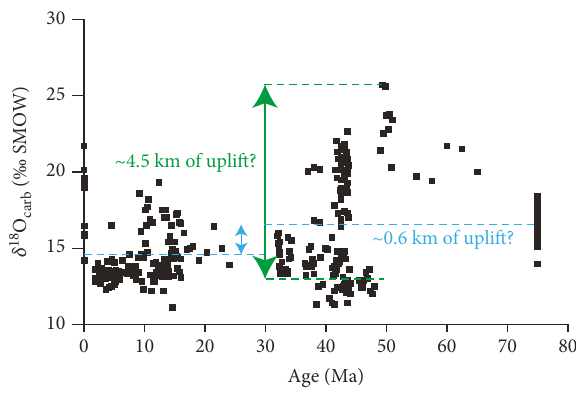
Figure 1: Plot of δ 18 O for the past 75Ma from Montana and carb Idaho. Data are from Chamberlain et al. [22]; age assignments re fl ect the assignments in the original data set; however, it should be noted that some of the individual sites have been redated subsequently (e.g., [47]). Shown in green is the maximum potential uplift between ~ 50 and ~ 30Ma ago, and in blue, a conservative estimate based upon long term means before and after a regional unconformity between 32 and 24 Ma ago. Uplift estimates are based upon the global δ 18 O lapse rate of Poage and Chamberlain